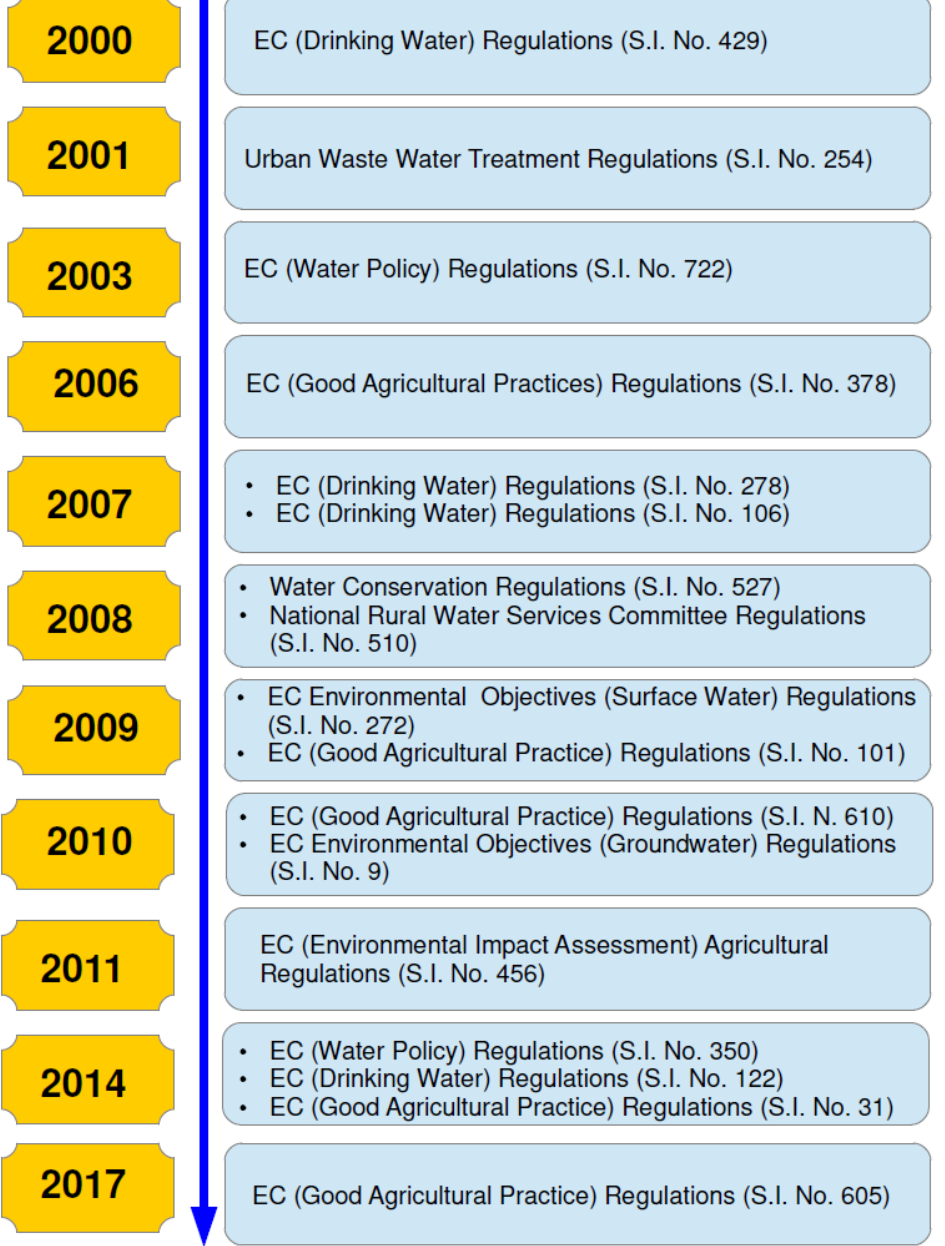
Figure 5. Legislation supporting water stewardship in Ireland in period of 2000–2017.